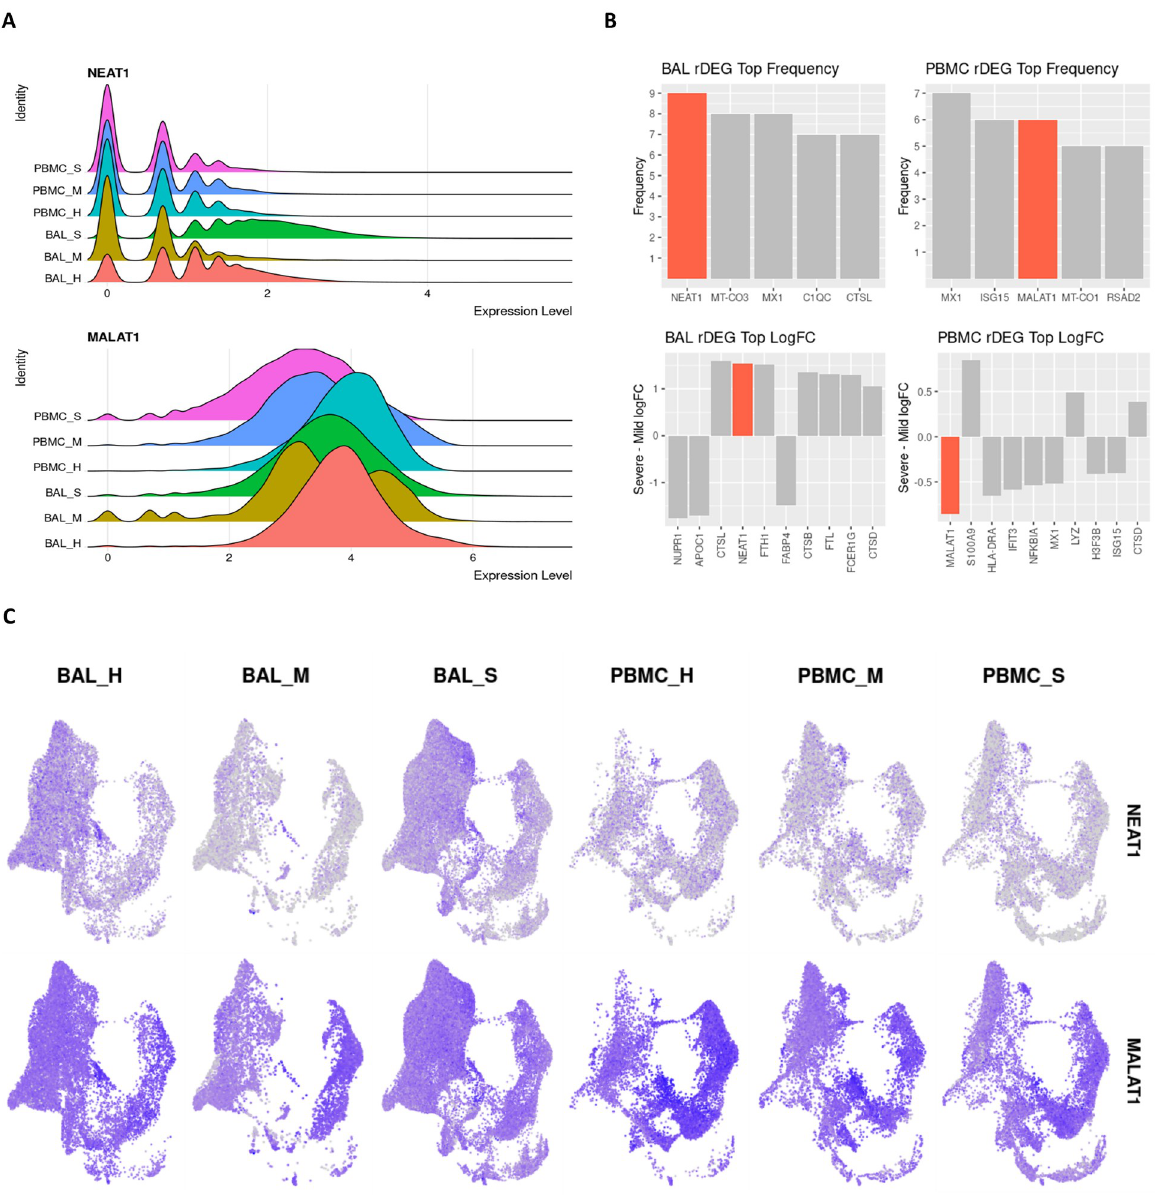
Fig 4. lncRNAs NEAT1 and MALAT1 are strongly differentially expressed between severe and mild patients and represent key inflammatory regulators in BAL and PBMC respectively. A . Violin plots showing overall expression level density across patient conditions in the entire dataset. Even at the full dataset scale, these distributions show that NEAT1 is overexpressed in BAL of severe patients while MALAT1 is underexpressed in PBMCs of severe patients. B . Frequency of detection across cell types for rDEGs shows NEAT1 as the most detected rDEG in BAL, with MALAT1 tied for second among rDEGs in PBMC. The top log2-fold change of rDEGs in severe versus mild patients also shows NEAT1 and MALAT1 among the rDEGs with the highest absolute change between severe and mild conditions. C . Visualization of NEAT1 and MALAT1 via UMAP projection shows more cell type localized expression in NEAT1. It is also clearly underexpressed in mild BAL cases. MALAT1 also shows a more subtle but significant underexpression in severe patient